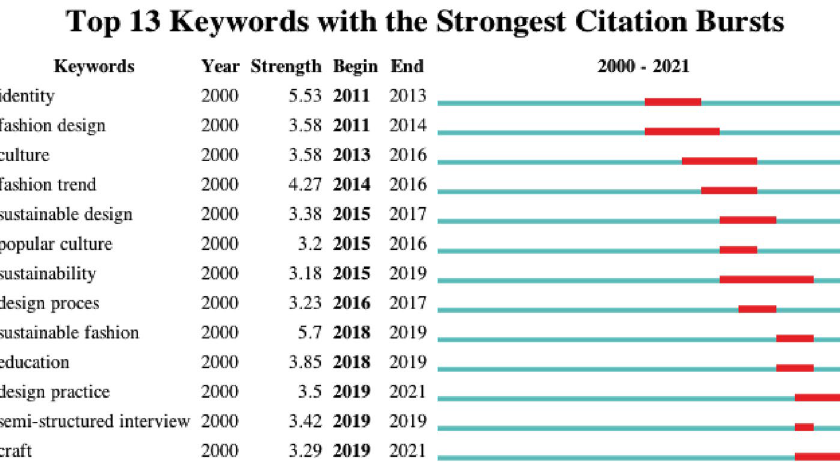
Fig. 7 Top 13 keywords with the strongest citation bursts in “fashion design”